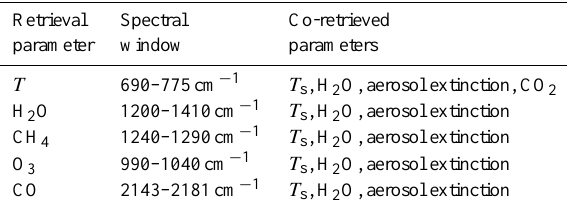
Table 2. Retrieval parameters and associated spectral windows and co-retrieved